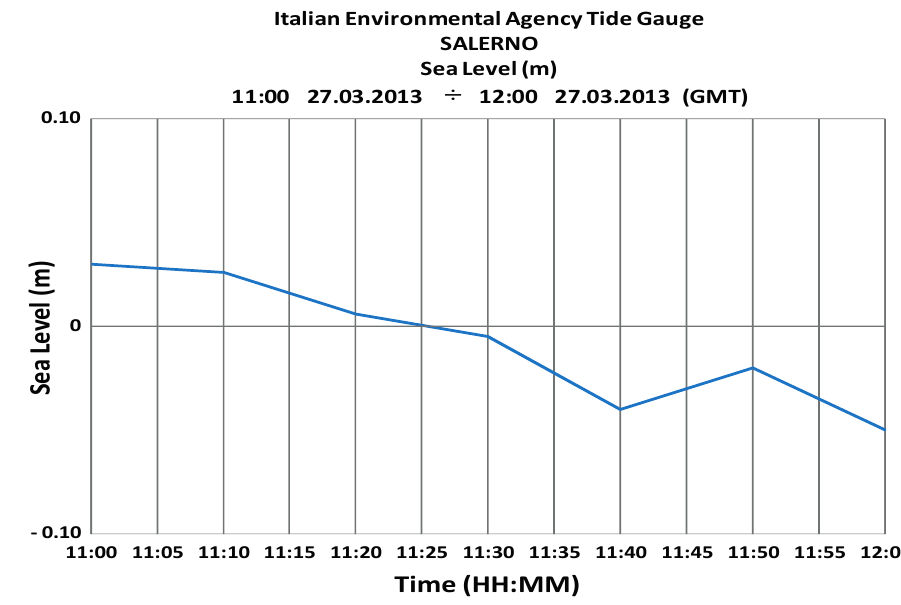
Figure 9. Tide level as measured by Italian Environmental Agency tide gauge during the